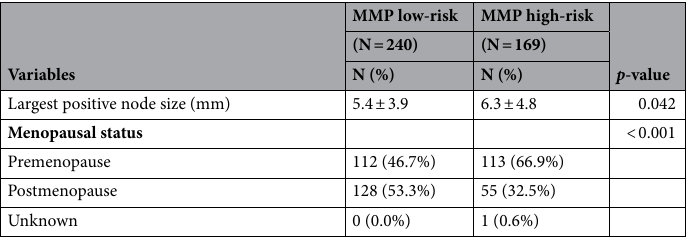
Table 1. Baseline characteristics of the patient cohort. MMP, MammaPrint; SD, standard